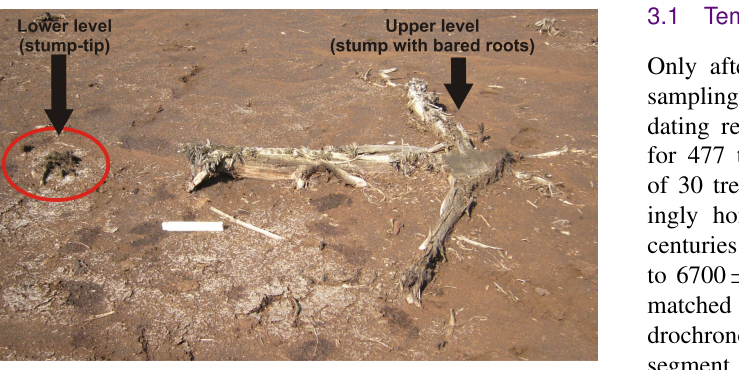
Figure 3. Tree stumps at site TOMO_south grown on two elevation levels. The upper level trees are sometimes supported by their dead successors. Photo: Inke